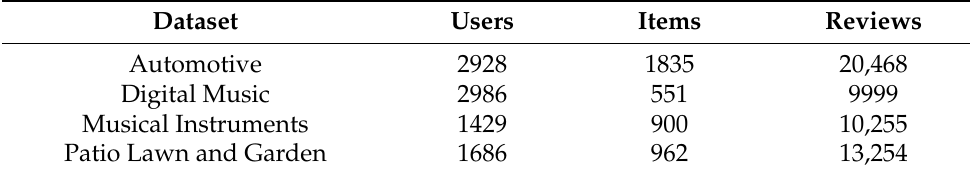
Table 2. Dataset